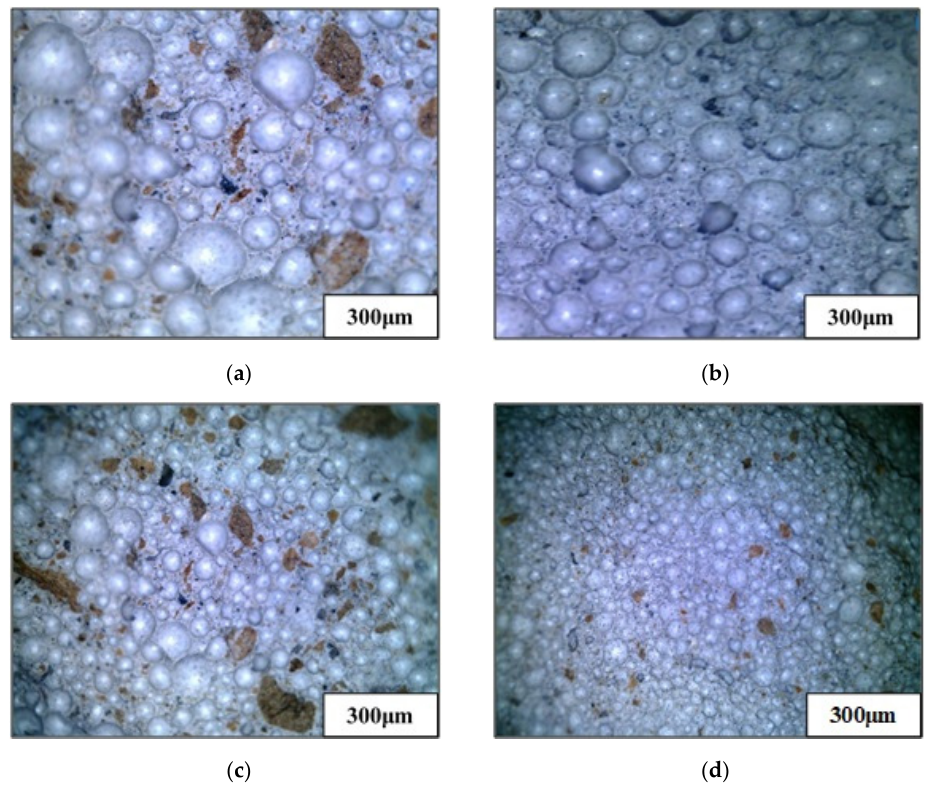
Figure 6. The topography of the foam backfill material with di ff erent densities at a 0.5 W / B ratio. ( a ) 600 kg / cm 3 foamed concrete; ( b ) 700 kg / cm 3 foamed concrete; ( c ) 800 kg / cm 3 foamed concrete; ( d ) 900 kg / cm 3 foamed